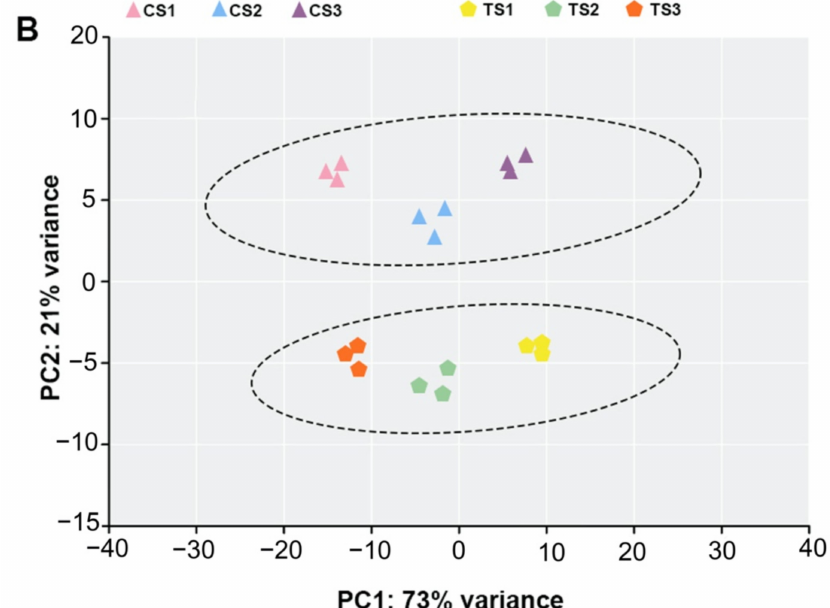
Figure 4. Statistics of global gene expression at different stages. ( A ): Number of detected transcripts in each sample. ( B ): Visualisation of principal component analysis (PCA) of all 18 samples in a 2D space. PCA was applied to Log2-transformed FPKM. Colour and shape indicate genotype and condition: CS1, stage (I) in control condition; CS2, stage (II) in control condition; CS3, stage (III) in control condition; TS1, stage (I) in treated condition; TS2, stage (II) in treated condition; TS3, stage (III) in treated